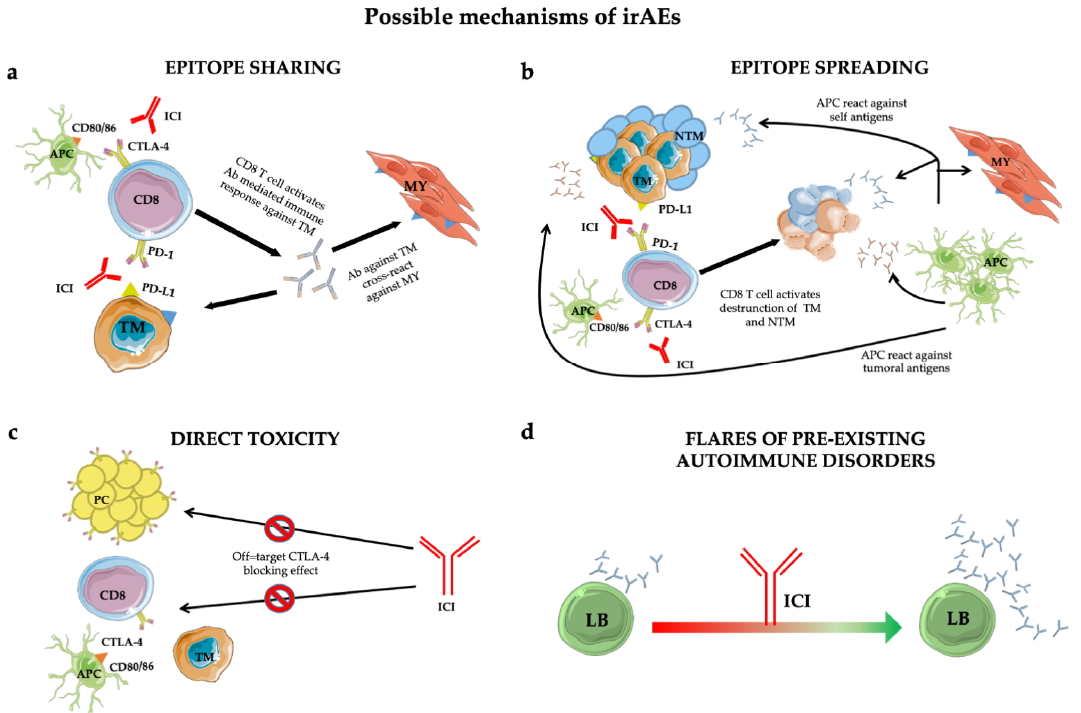
Figure 1. Mechanisms of immune-related adverse events (irAEs): epitope-sharing ( a ); -spreading ( b ); direct toxicity ( c ) and flares of pre-existing autoimmune disorders ( d ). See text for details. Abbreviations: ICI = immune checkpoint inhibitor; TM = tumoral cell; MY = myocytes; Ab = antibody; NTM = non tumoral cell; APC = antigen presenting cell; PC = pituitary cell; LB = B